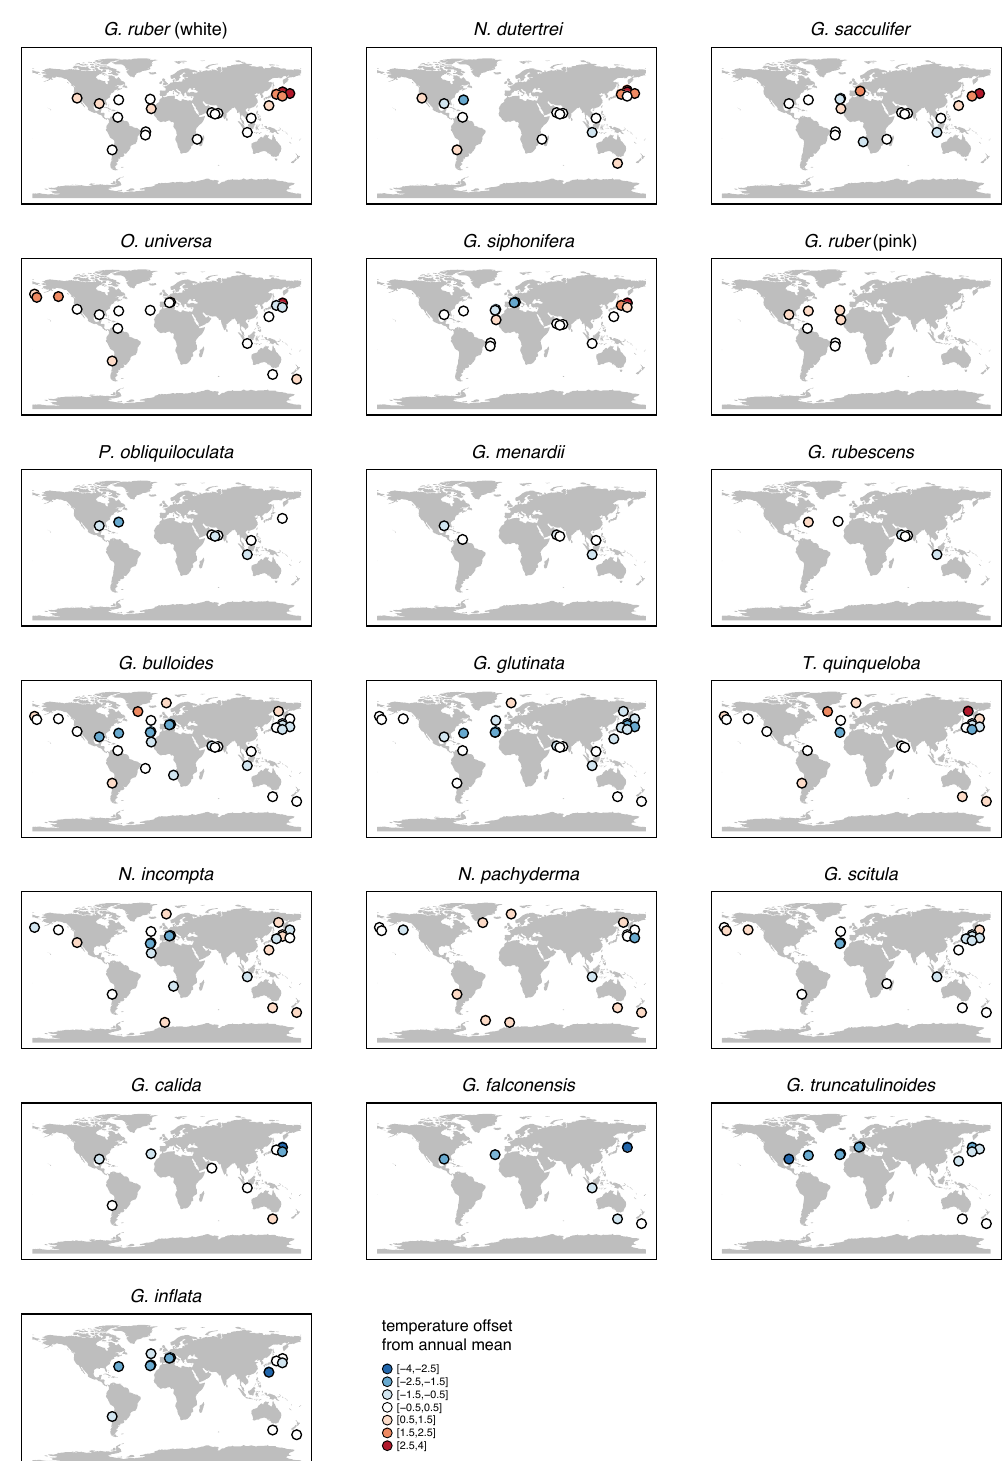
Figure 9. Offset from mean temperature (0–50m water depth) due to seasonality. Positive offsets indicate that flux-weighted temperature is higher than mean temperature and vice